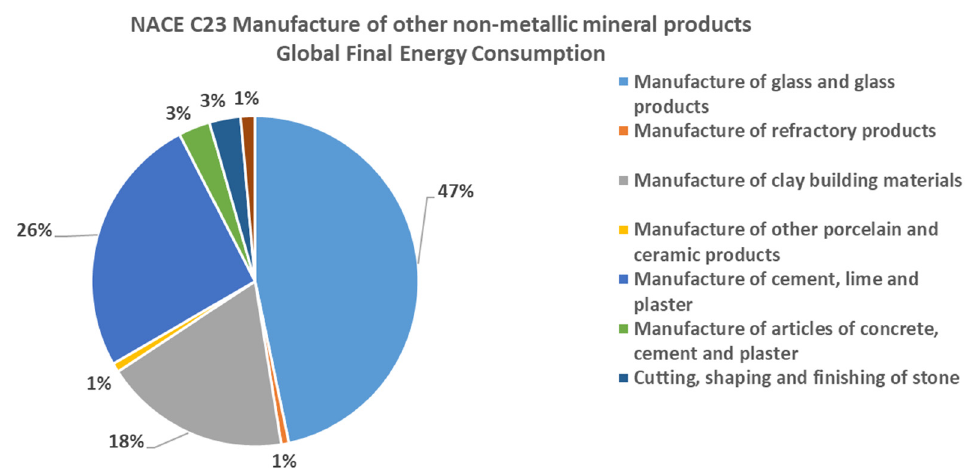
Figure 6. NACE C23 EAs groups’ global final energy consumption distribution.